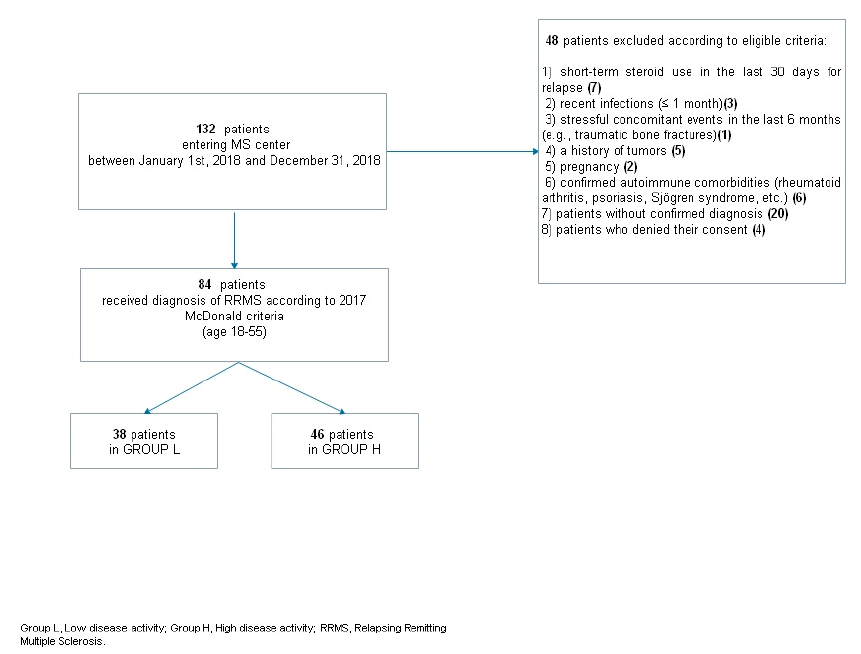
Figure 1. Patients’ selection flow chart. RRMS; relapsing–remitting multiple sclerosis.